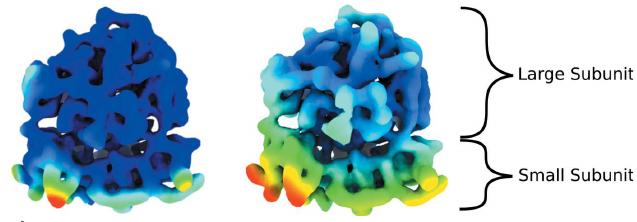
Figure 2 Mitochondrial ribosome subunits 28S and 39S (from EMDB entry 1720) coloured using the strain (left) and rotation (right) components extracted from the deformation coefficients obtained when analysing the motion described by EMDB 1720 and EMDB 1723. The conformational change described by these two maps is represented in Video